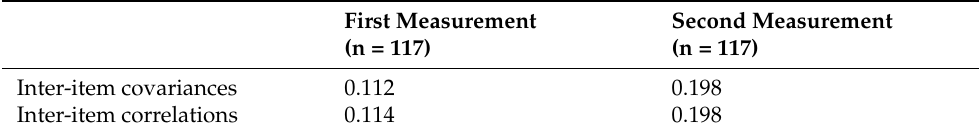
Table 2. Inter-item covariances and correlations in the DSMQ.